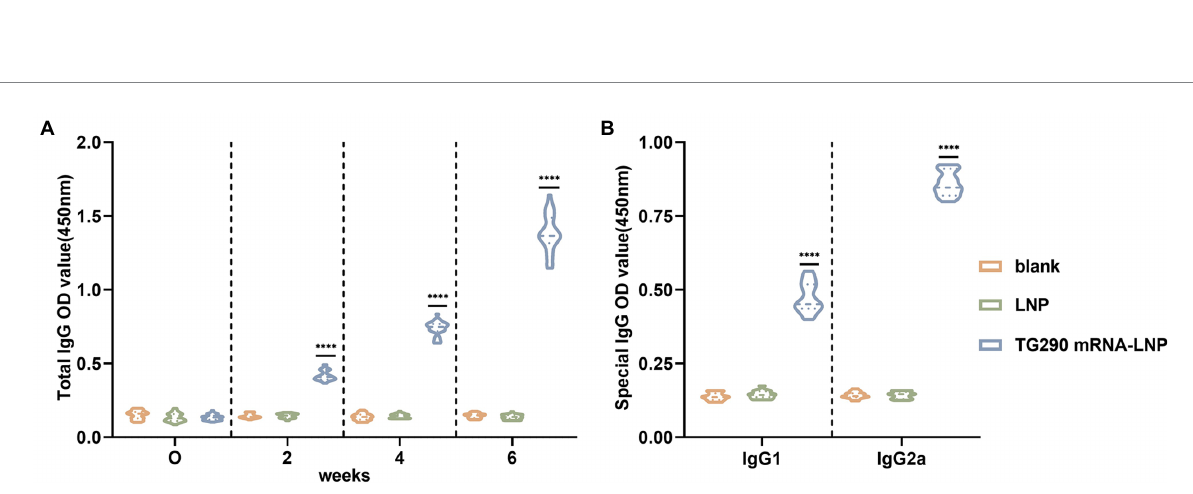
mRNA-LNP than in the blank and LNP groups ( p < 0.0001). Additionally, TG290 mRNA-LNP vaccination significantly promoted increased levels of MHC-I (Figure 6E) and MHC-II (Figure 6F) molecules ( p < 0.0001). Taken together, these results indicate that TG290 mRNA-LNP elicits higher levels of the CD83 and CD86 molecules of DCs and plays a critical role in the antigen presentation effects of DCs.